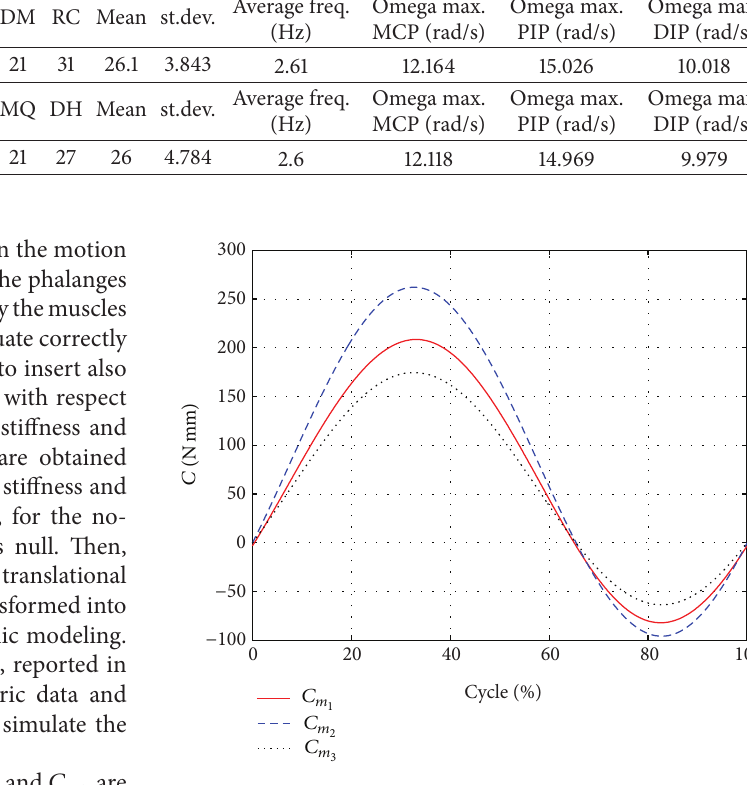
Figure 6: Trend of the muscle torques. Table 10: Percentages of stiffness, damping, and inertial torques with respect to the total